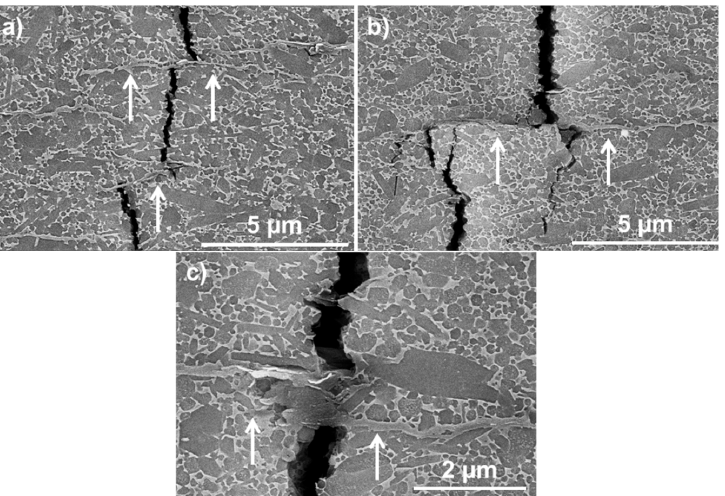
Figure 4. ( a ) Hardness (H) and fracture toughness (K IC ) evolution along the cross-section of the Si 3 N 4 /rGOs FGM. K IC was obtained by the indentation fracture (IF) method. ( b ) K IC values obtained by SCF method for monolithic Si 3 N 4 FGM and Si 3 N 4 /rGOs FGM tested on the α - and β -phase surfaces.